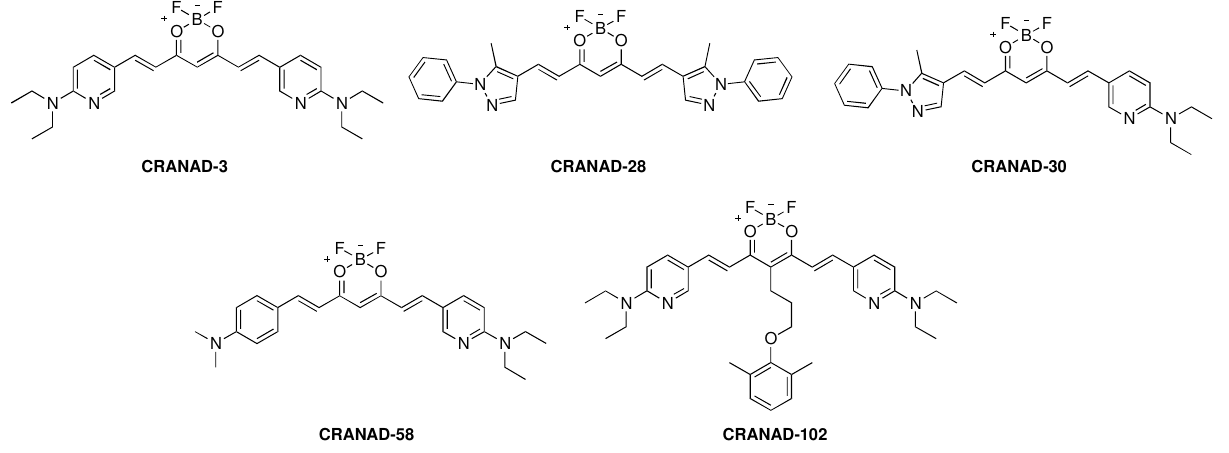
Figure 3. The chemical structures of CRANAD−X (X = 3, 28, 30, 58 and 102). An aniline and a more hydrophilic pyridyl moiety were introduced in CRANAD-58 [52]. In vitro study demonstrated that it has good fluorescence qualities (ex = 630 nm, em = 750 nm), with a fluorescence intensity increase of 91.9- and 113.6-fold for Aβ40/Aβ42 monomers respectively. However, compared to CRANAD-2, its binding affinity de- creased (Aβ40: K d = 105.8 nM, Aβ42: K d = 45.8 nM). In order to increase binding ability, CRANAD-3 was designed by Ran and co-workers though replacing phenyl rings with pyridyl to introduce possible hydrogen bonds [53]. CRANAD-3 displayed high interac- tion with Aβ40/42 monomers, dimers, and oligomers ( K d = 24 ± 5.7 nM, 23 ± 1.6 nM, 16 ± 6.7 nM, and 27 ± 15.8 nM, respectively). CRANAD-3 (Figure 4A,D) and CRANAD-58 (Fig- ure 4B,E) can both distinguish between 4-month-old APP/PS1 and WT mice. In 2017, Ran ble Aβ species. The stereo-hindrance of CRANAD-3 was adjusted by adding phenoxy- alkyl chains to the dioxaborine’s central carbon. CRANAD-102 [54], a hit as a result of this finity (7.5 and 275 nM, respectively). In addition, CRANAD-102 could dynamically mon- itor the concentration of soluble Aβ in 5-month-old and 12-month-old AD transgenic mice (Figure 4C,F). In 2022, Liu group developed nine fluorescent probes to detect both soluble